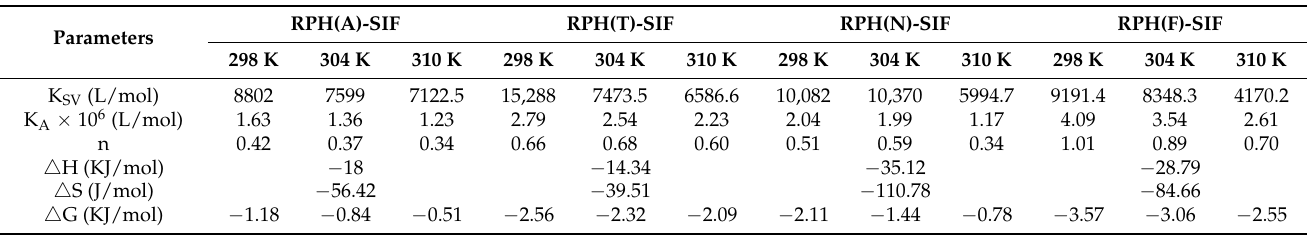
Table 2. Relevant parameters of the Stern-Volmer quenching constant and the values of thermody- namic parameters.